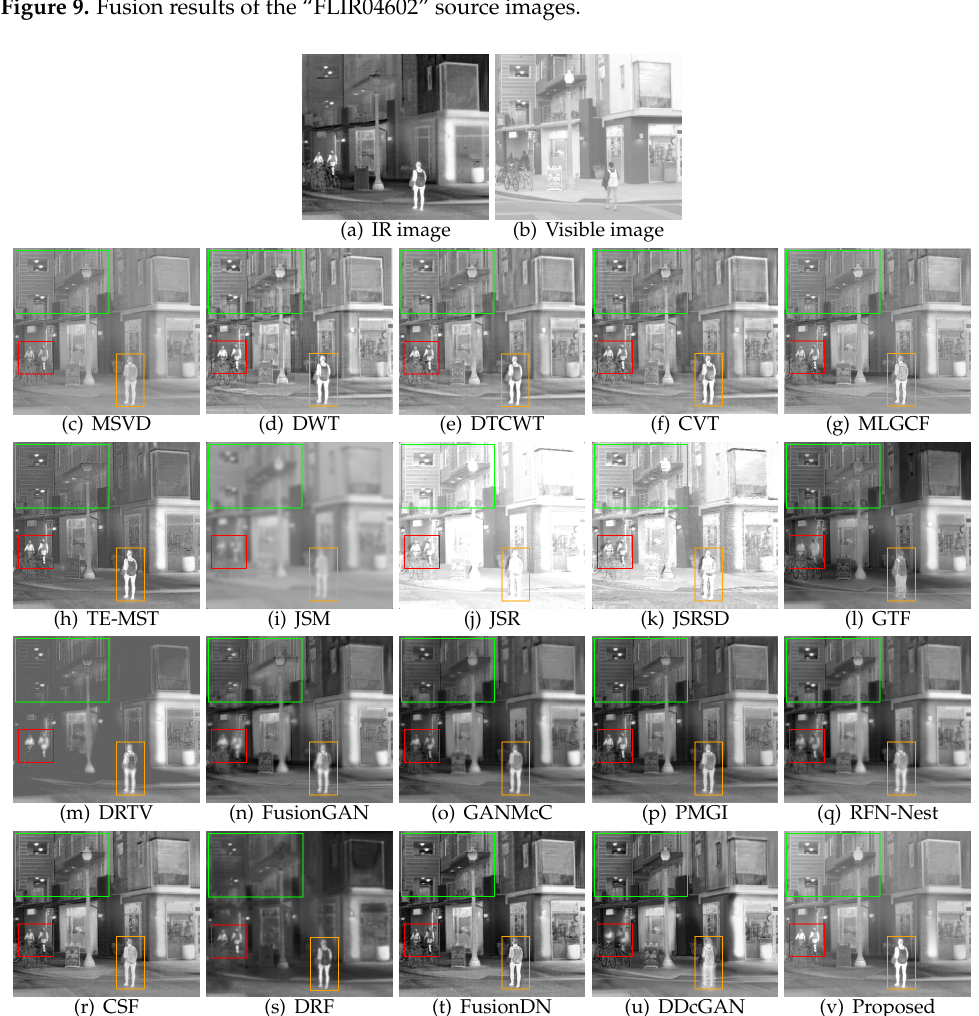
Figure 10. Fusion results of the “FLIR08835” source